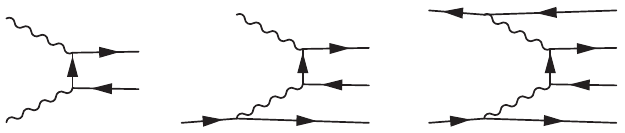
FIG. 6. Feynman diagrams for incoherent pairs and incoherent muons. From left to right: the Breit-Wheeler, Bethe-Heitler, and Landau-Lifshitz processes. For each of these u -channel diagrams, there is a corresponding t -channel diagram (which means con- necting each photon to the opposite virtual fermion